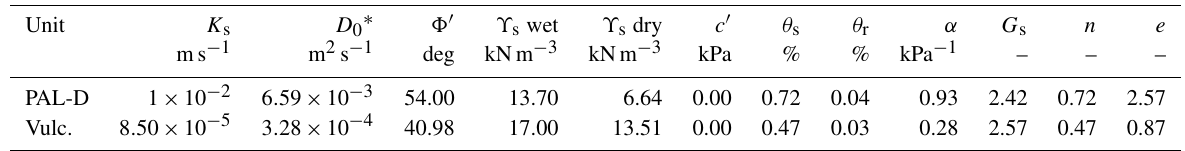
Figure 4. (a) Lahar levee deposit (sample V5 in Fig. 1) above the 1888–1890 tephra fallout, located in a channel cut on the S of the La Fossa cone. (b) Lahar deposit (sample V6) above the 1888–1890 tephra fallout in the Palizzi valley. (c) The profile observed at the beachside in Porto di Ponente (1) is a 14cm bed of coarse ash, with a 1cm thick grey fine ash grey layer; this is the primary 1888–1890CE tephra fallout. Layer V7-1 is a 26cm lahar deposit of coarse ash to fine lapilli inversely graded. Layer V7-2 is an 11cm fine lapilli lahar deposit with 1cm of soil on the top. V7-3 is a 10cm lahar deposit of coarse to fine ash with soil on the top and a 6cm lahar deposit (V7-4) of coarse to fine ash with recent soil on the top. (d) Several lahar deposits located in a channel on the NW of the La Fossa cone: the first deposit above 1888–1890 was sampled (V9 in Fig. 1). (e) Lahar deposits located in a channel on the NW of the La Fossa cone on the top of the 1888–1890 tephra fallout deposit. Table 2. Geotechnical parameters for the subplinian tephra fallout deposit (PAL-D) and the Vulcanian tephra fallout deposit associated with the 1888–1890 eruption